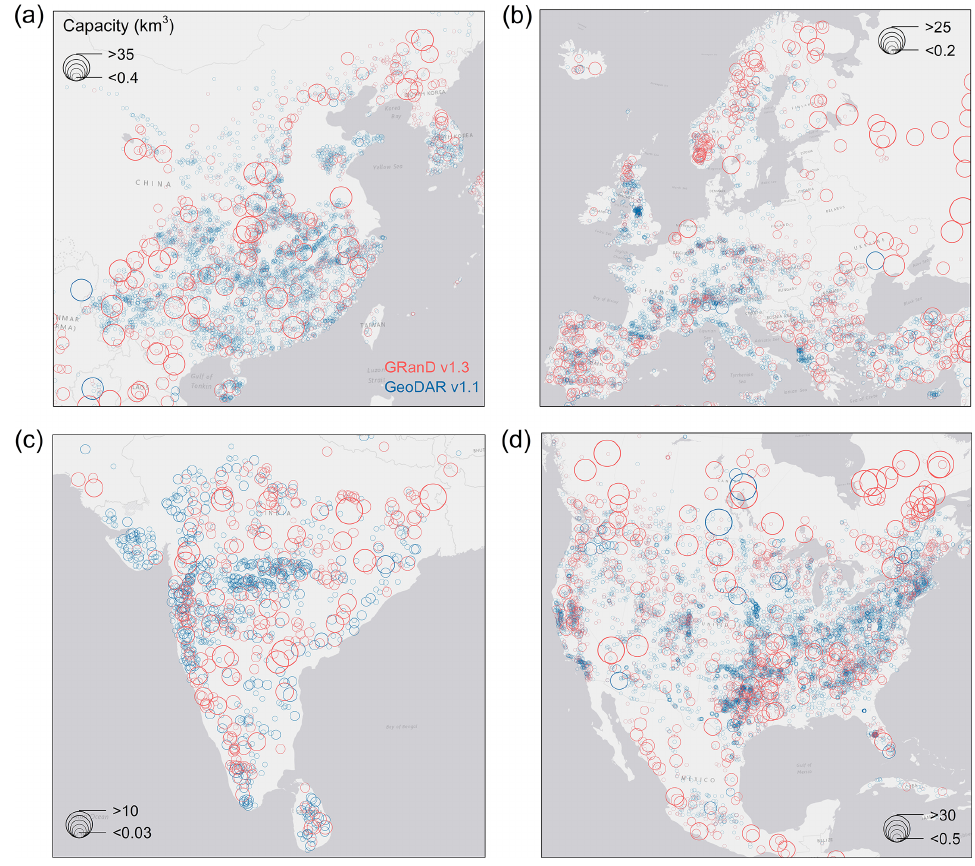
Figure 13. Regional distributions of reservoir storage capacities in GRanD v1.3 and GeoDAR v1.1. (a) China and its surrounding East and Southeast Asia. (b) Europe. (c) India and its surrounding South Asia. (d) US and its surrounding North America. Graduated symbols for GeoDAR (blue bubbles) are superimposed by symbols for GRanD (red